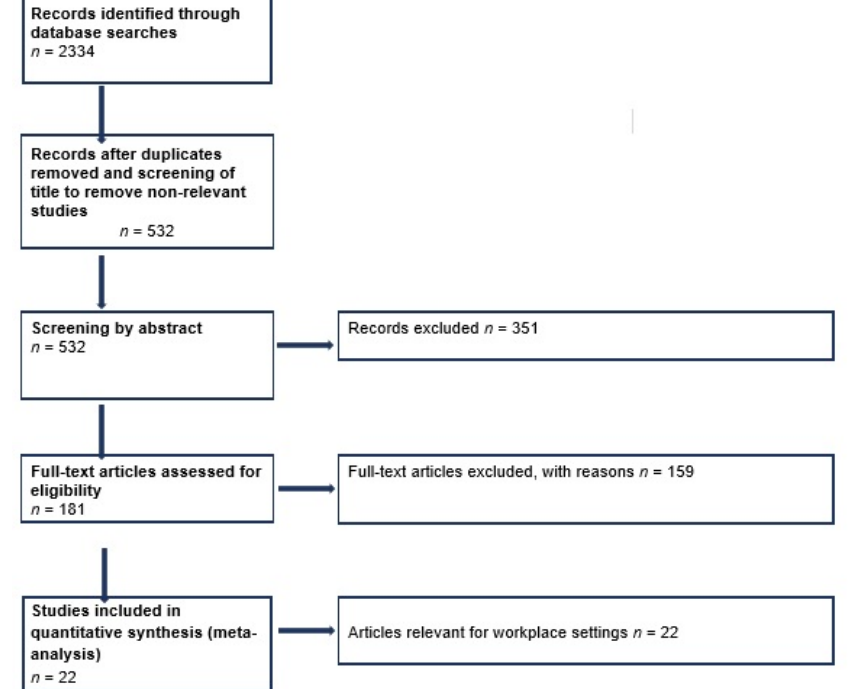
Figure 1. PRISMA Flow Diagram for sampler comparison review.